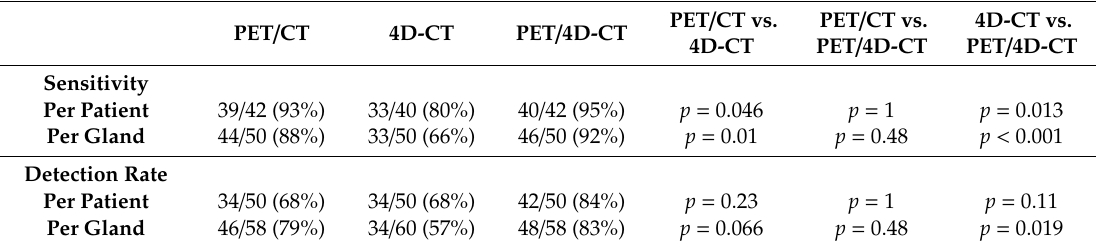
Table 3. Head-to-head comparison between PET / CT, 4D-CT, and PET / 4D-CT in the whole population including 50 patients and 54